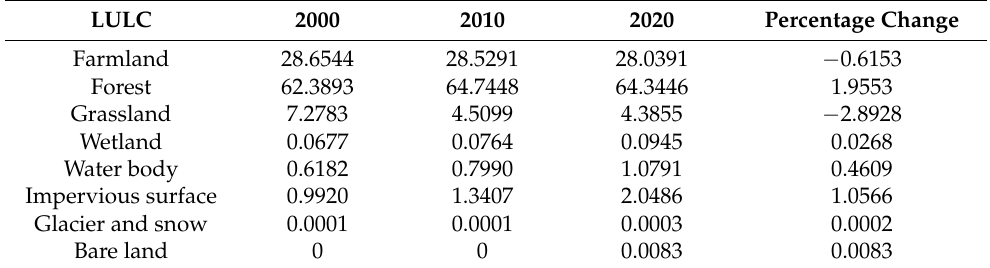
Table 2. Percentage of LULC changes in the Qinling-Daba Mountains in 2000, 2010, and 2020 (Unit: km 2 ).